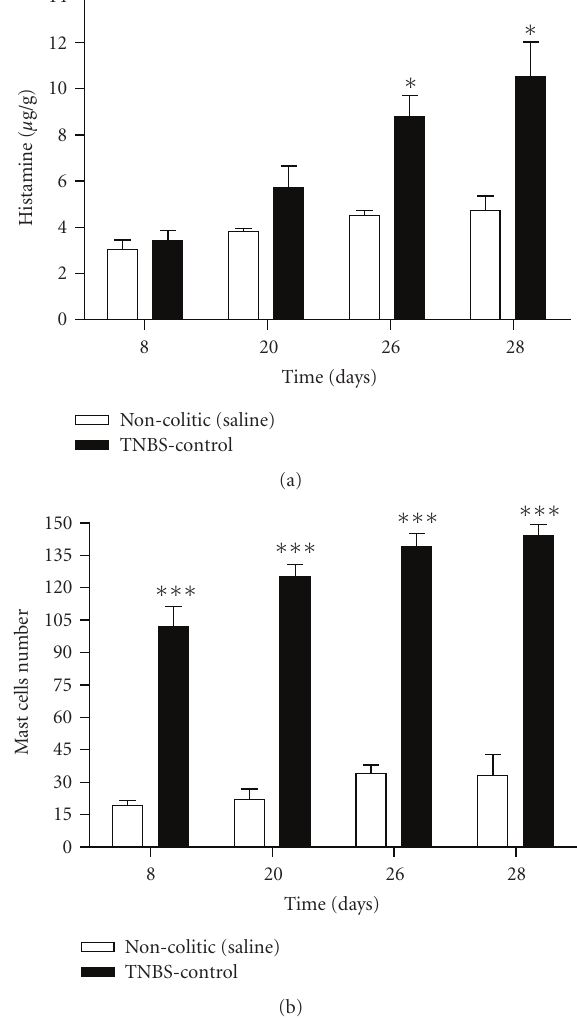
Figure 2: Histamine concentration and mast cells number in colon of Wistar rats with colitis induced by TNBS. The results are expressed as mean ± SEM ( n = 5–7). ∗ P < . 05; ∗∗∗ P < . 001 (by Student’s t